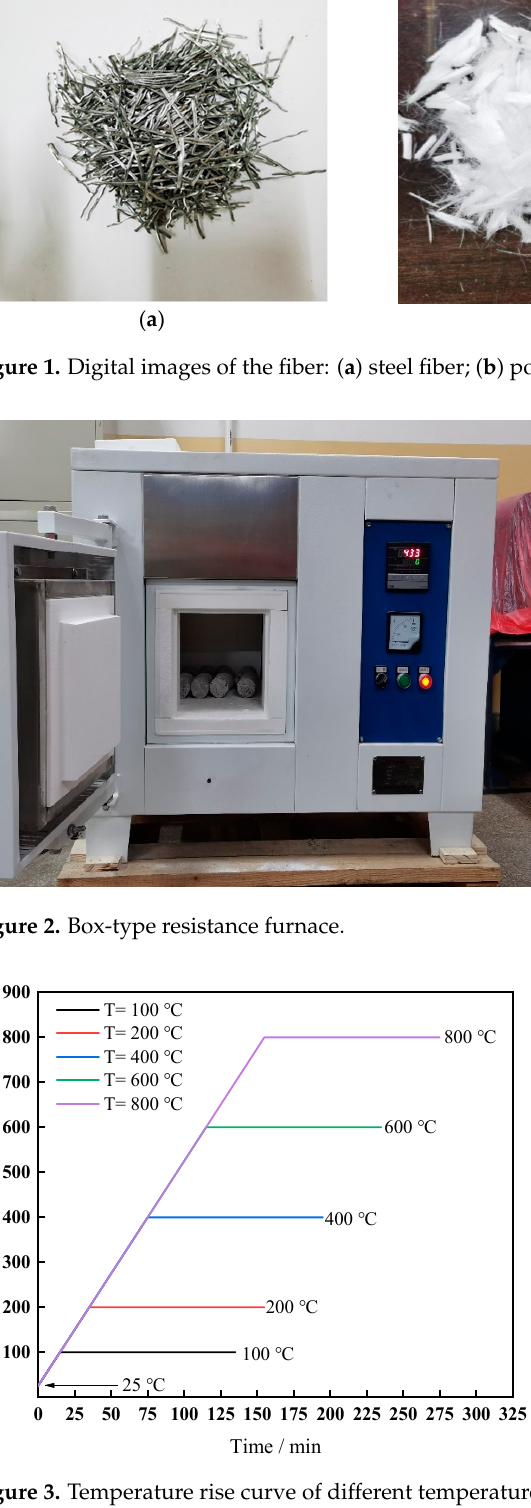
Figure 1. Digital images of the fiber: ( a ) steel fiber; ( b ) polypropylene fiber.